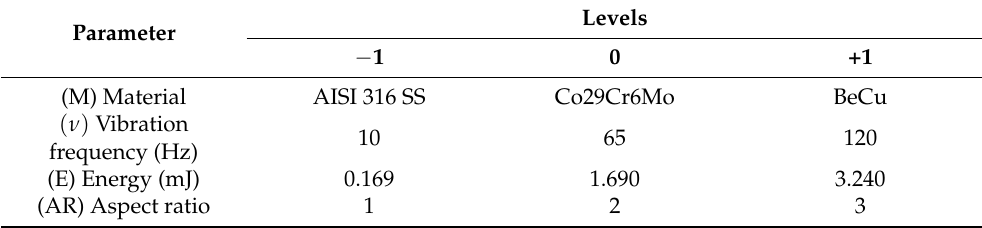
Table 2. Input – output table.